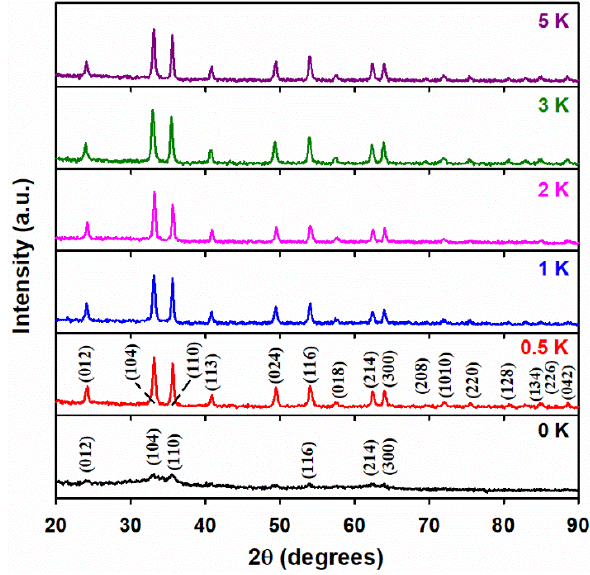
Figure 1. X-ray diffraction (XRD) patterns of 100 Fe: x K materials, with the atomic ratio of potassium ( x ) indicated in each panel. The assigned Miller indices match the hematite phase of iron oxide.